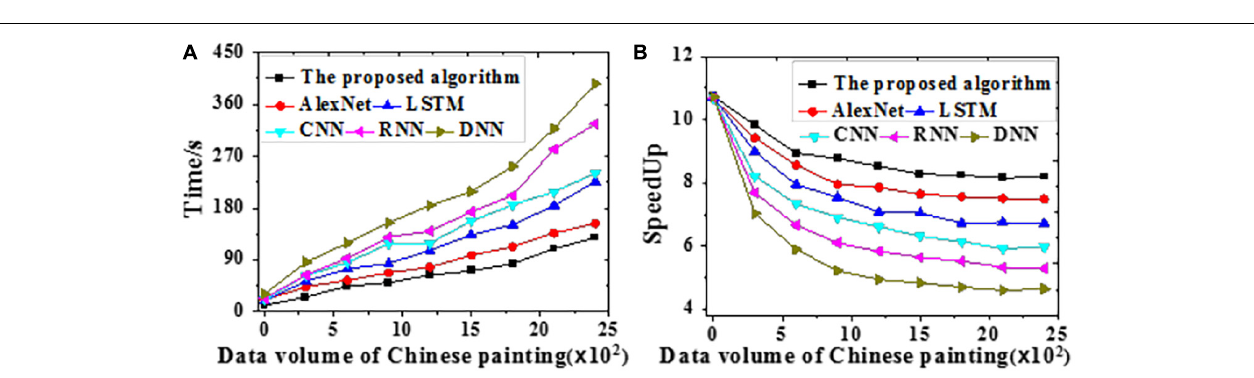
FIGURE 10 | The time required and speedup ratio of different models under different data volumes on the test dataset [ (A) Time required; (B) Speedup